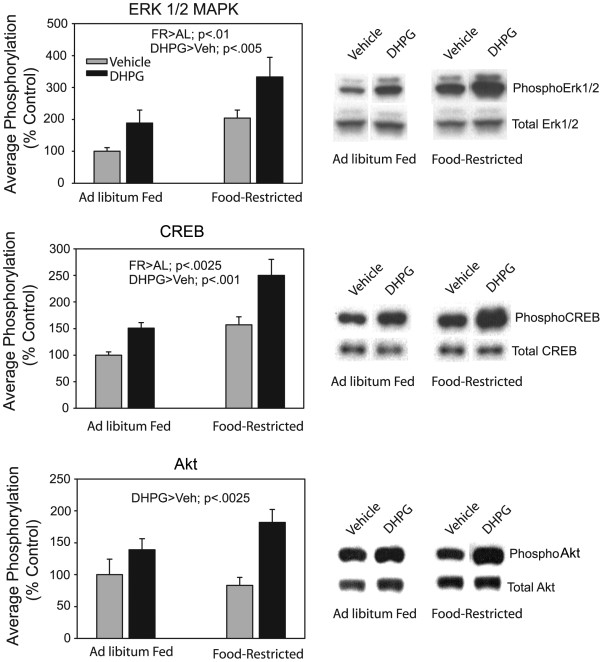
Effects of DHPG on activation of ERK1/2, CREB and Akt in Nucleus Accumbens Ad libitum fed and food-restricted rats received i.c.v. injections of DHPG (500 nmol) or saline vehicle prior to sacrifice. Lysates were immunoblotted with anti-phospho ERK1/2 or anti-ERK1/2 (top), anti-phospho-CREB or anti-CREB (center), or anti-phospho-Akt or anti-Akt (bottom) antibodies. Following densitometry, intensities of bands corresponding to phosphorylated proteins were divided by intensities of the corresponding total protein bands to correct for small differences in protein loading. Results (mean ± S.E.M.) are expressed in comparison to the normalized control, which was defined as the ad libitum fed group injected with vehicle. Graphed results are displayed with representative immunoblots.